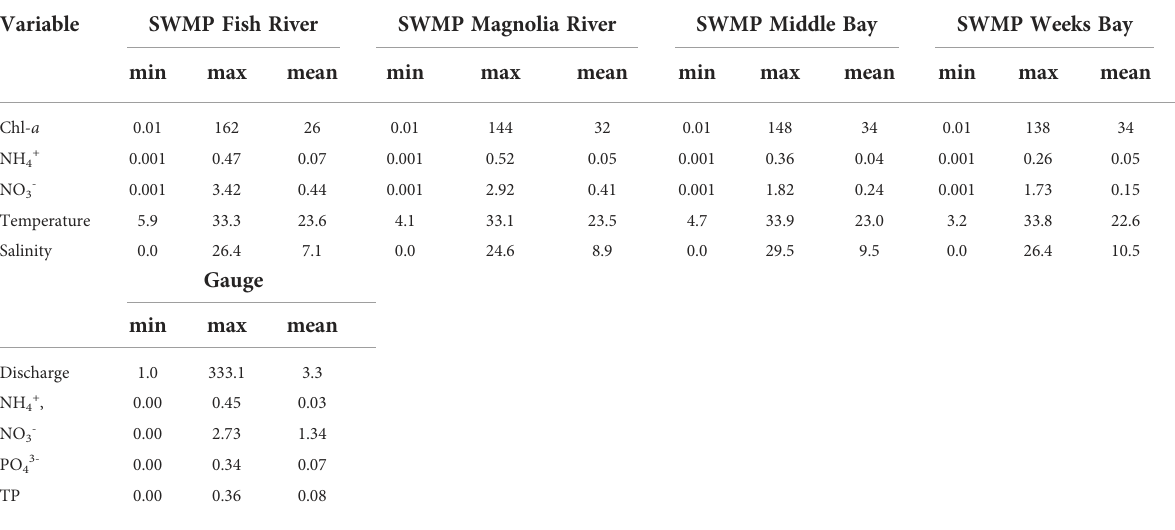
TABLE 1 Summary of chl- a and environmental variables.